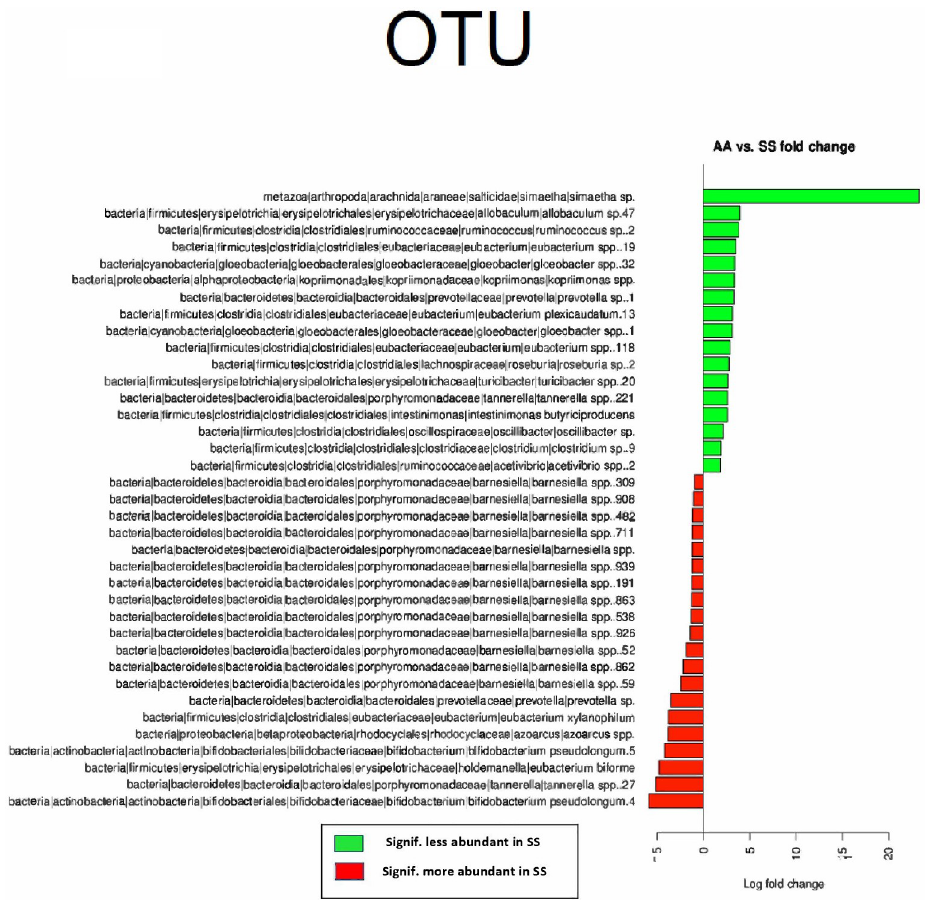
Fig 6. Differential OTUs between SS and AA townes mice stool